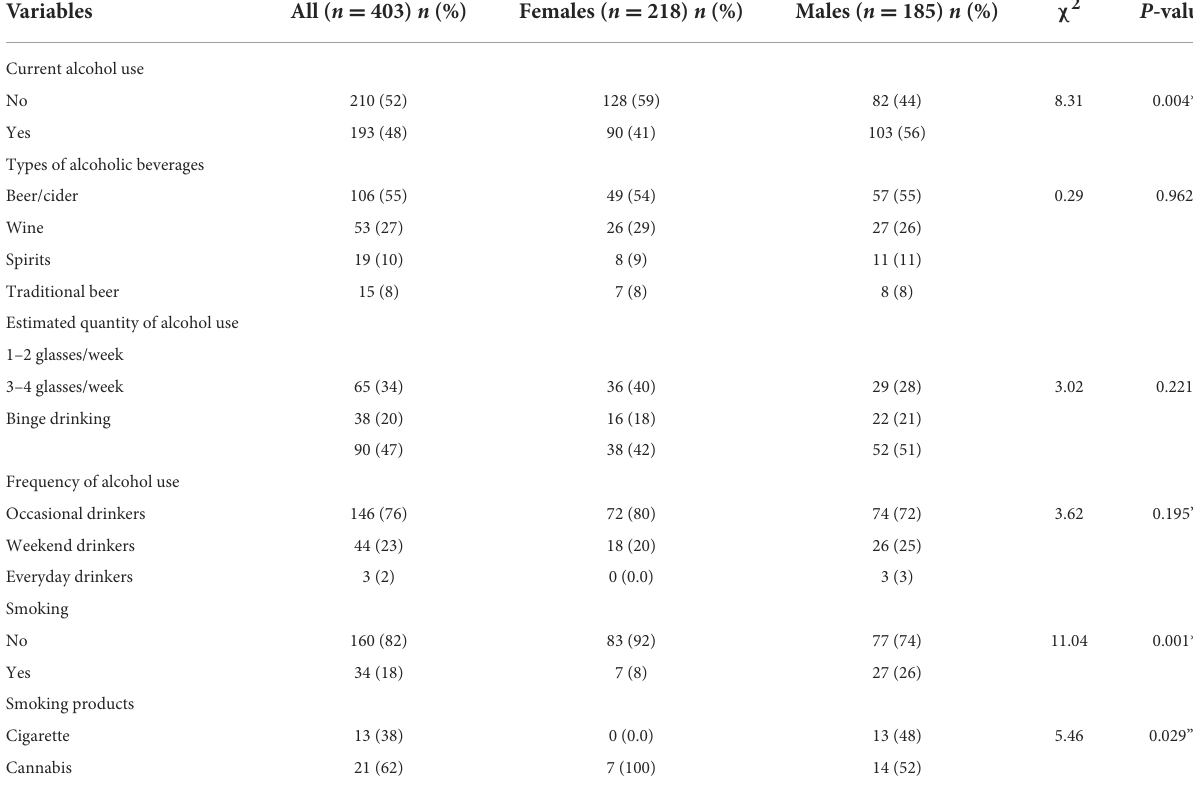
TABLE 2 Comparison of current alcohol and tobacco use and products among adolescents by